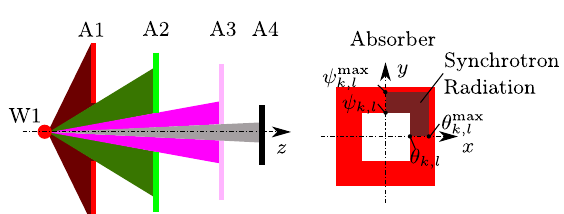
FIG. 18. Beam-pipe ellipse.